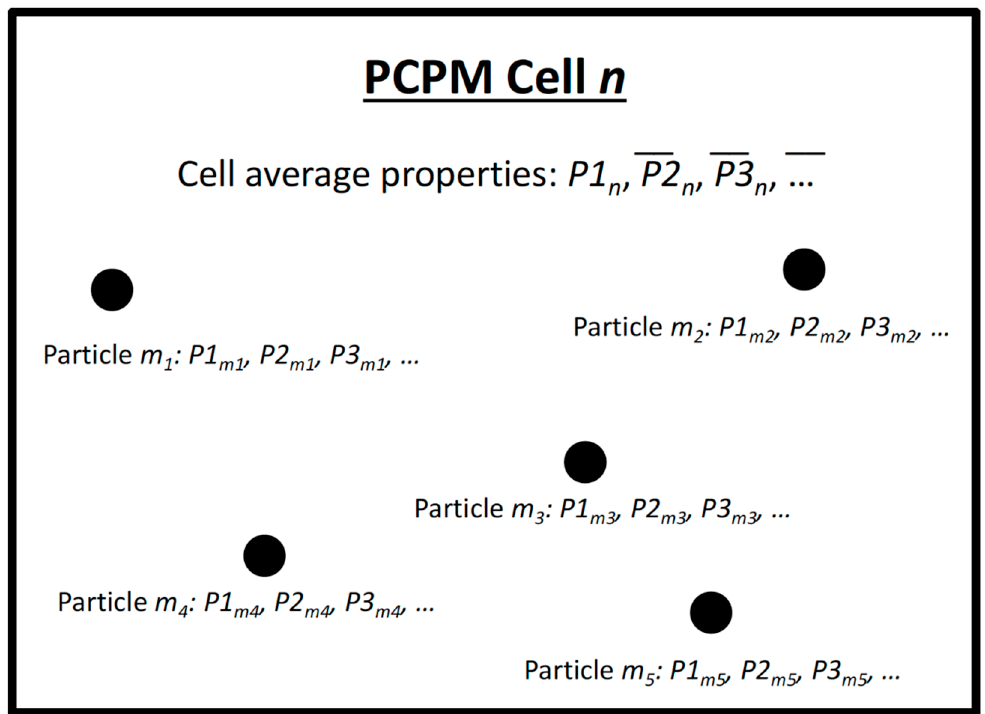
Figure 2. Conceptual representation of a property-carrying particle model (PCPM) computational cell n and particles ( m 1 , m 2 , m 3 , m 4 , m 5 . . . ) within the cell n. PCPM cell-based average of each property ( P 1 n , P 2 n , P 3 n , . . . ) is determined by the property values carried by the particles that have entered in this cell. After time evolution of PCPM properties using process equations, the updated PCPM cell-based properties ( P 1 n , P 2 n , P 3 n , . . . ) are redistributed to particles with a weighted average. The particles then move around carrying the updated properties to different PCPM computational cells in the next cycle.